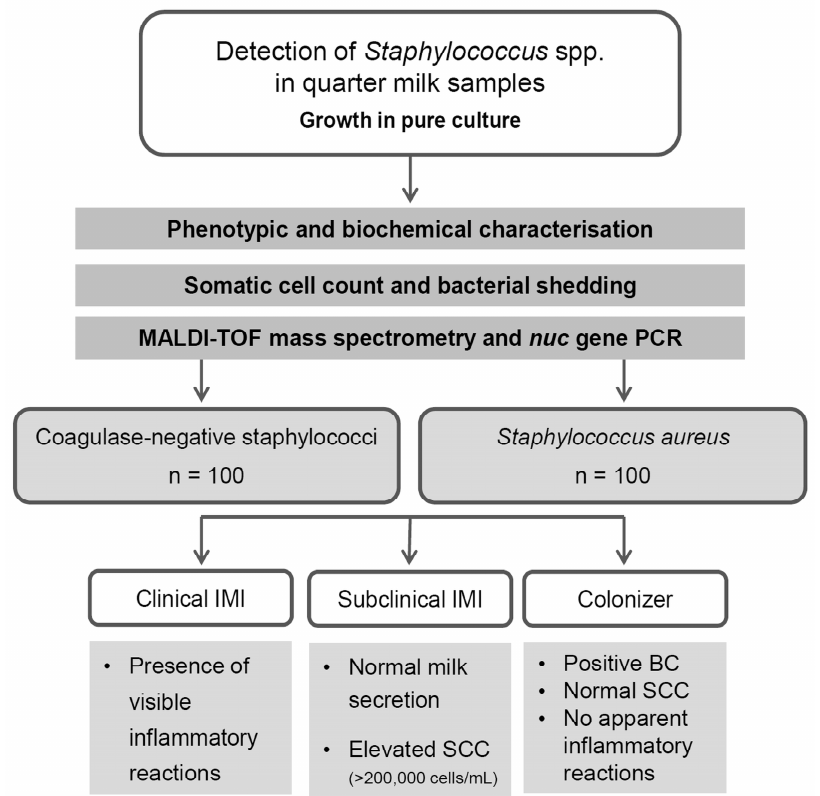
Figure 1. Study group formation of the staphylococcal isolates collected from March to September 2017 in routine diagnosis. (MALDI-TOF = matrix-assisted laser desorption ionization time of flight; PCR = polymerase chain reaction; IMI = intramammary infection; SCC = somatic cell count; BC = bacteriological culturing).